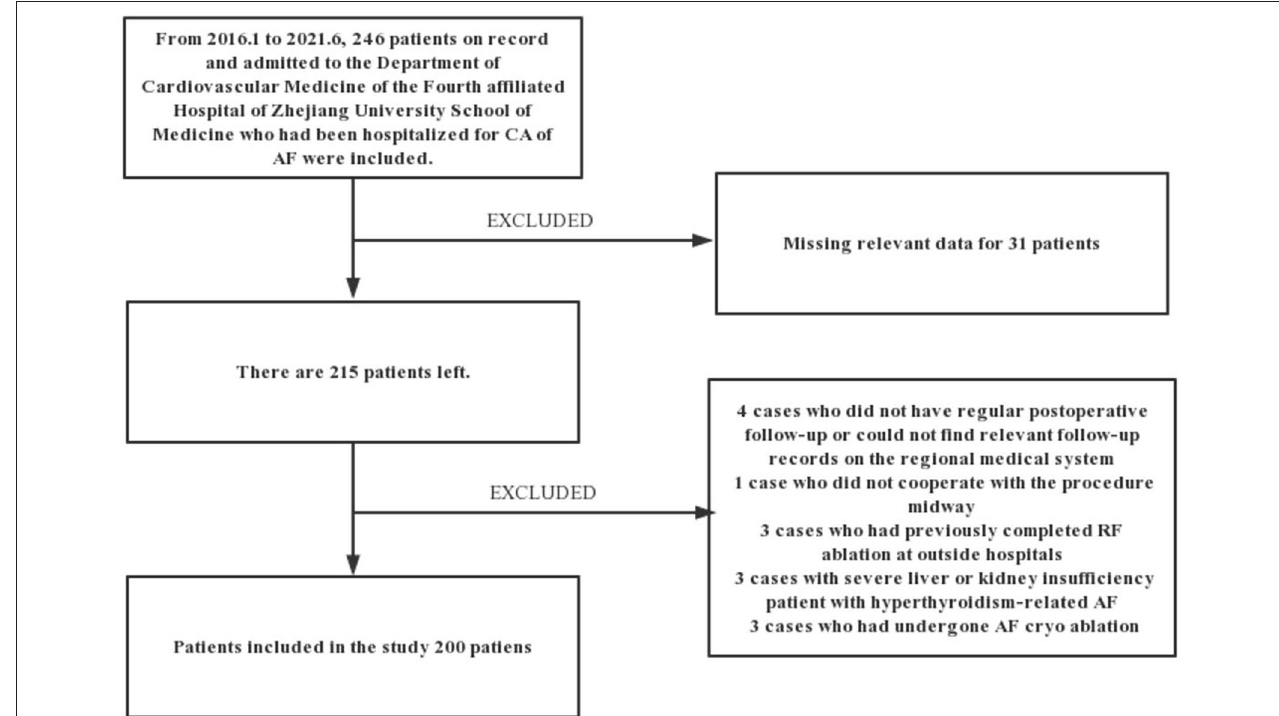
FIGURE 1 | Flowchart of the study.